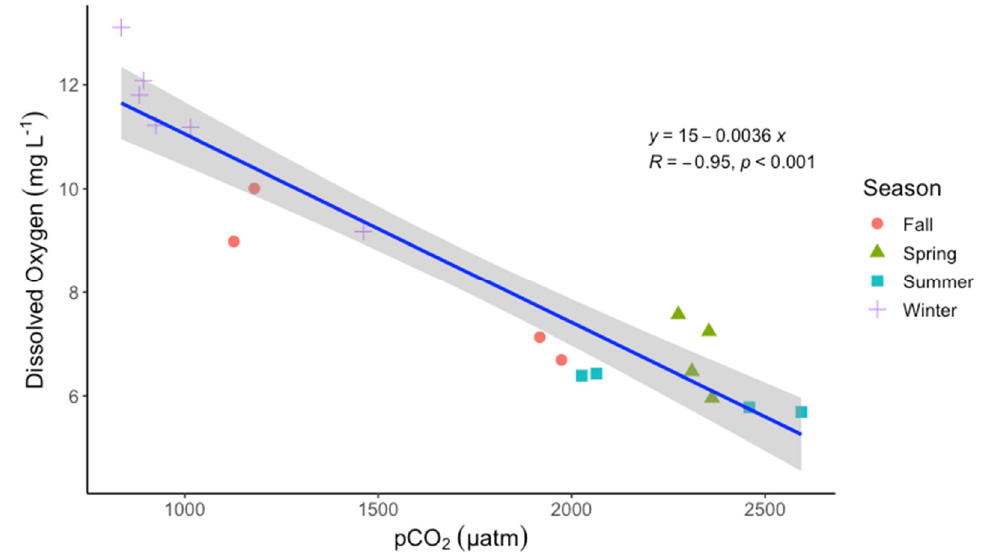
Figure 6. Inverse relationship of river dissolved oxygen content and p CO 2 .